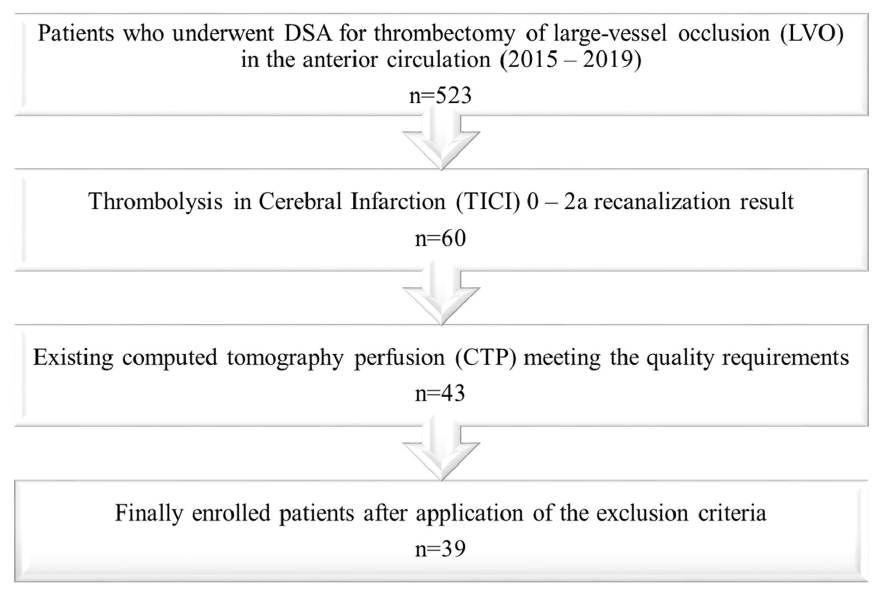
Figure 1. Flow chart illustrating the patient selection process.